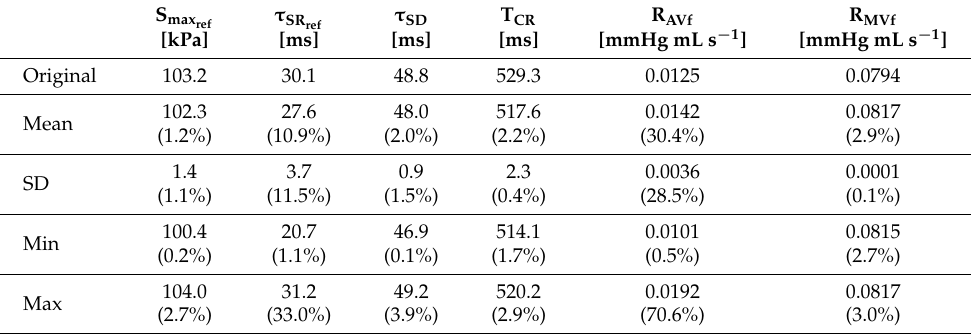
Figure 6. Effect of clinical data uncertainty on simulated left ventricular pressure and volume in the two steps of the active mechanics personalisation approach. The blue/red lines represent the simulation data (Sim 1 , Sim 2 ) that were produced by the 3D model of human left ventricular EM in the first/second step of the active mechanics personalisation approach. The active mechanics personalisation was performed based on ten samples of clinical biomarkers ( ± 10% around the measured value) and the resulting pressures and volumes (light colours) are compared to those that resulted from the personalisation based on the measured values (bold colours). ( a ) Pressure–volume loops, ( b ) pressure traces, ( c ) volume traces. Table 7. Results of the initial guess variation robustness analysis for the patient case 02-CoA. Esti- mated model parameters of the first step of the active mechanics personalisation approach are given. The original values produced by the default initial guesses are listed in the first row and means (M), standard deviations (SD), minima (Min), and maxima (Max) of five samples are listed in the subsequent rows. Means, standard deviations, minima, and maxima of the relative differences are given in brackets